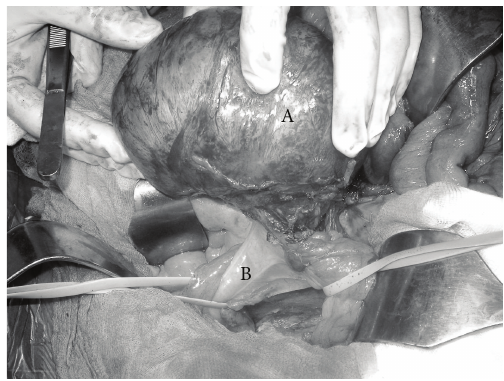
Figure 3: Intraoperative view: A: desmoid-type fibromatosis (15 × 10 × 6.5 cm); B: sigmoid colon